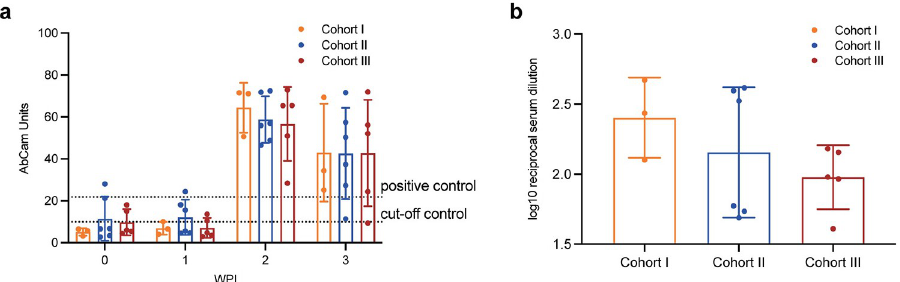
Fig 6. All ZIKV-exposed animals developed robust IgM and neutralizing antibody responses. (a) ELISA determined Anti-ZIKV IgM levels at 0, 1, 2, and 3 weeks post infection (WPI). (b) Neutralizing antibody levels were measured at baseline and 17, 20, or 27 days post infection (DPI) by PRNT 90. Bar graphs depict the mean antibody levels for each cohort at the respective timepoints. Error bars represent the standard